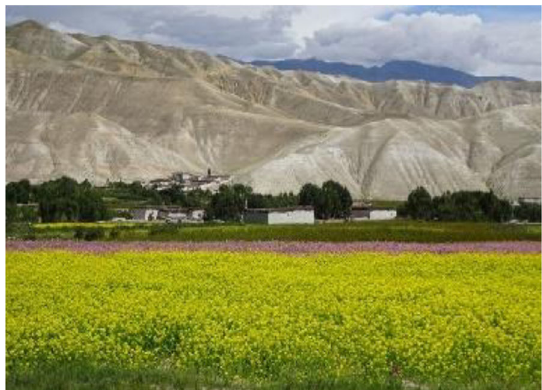
Fig. 7 Colorful agriculture field and desert type of surrounding outside field area (photo credit to Sontosh Sherchan